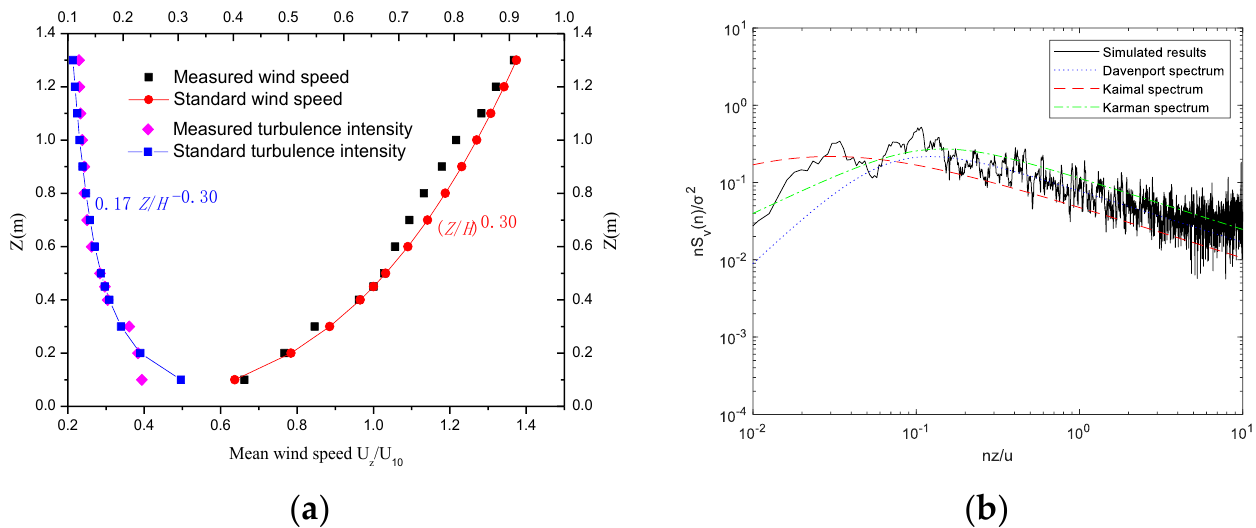
Figure 1. Approach flow condition for exposure D. ( a ) Mean velocity and turbulence intensity profiles; ( b ) Longitudinal wind velocity fluctuations spectrum at 2/3 building height.